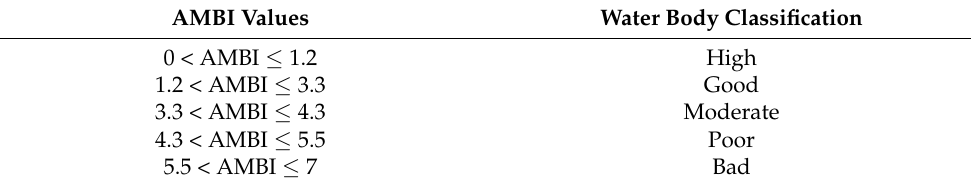
Table 1. AMBI values and relative water body classification. Key: AZTI’s Marine Biotic Index (AMBI).